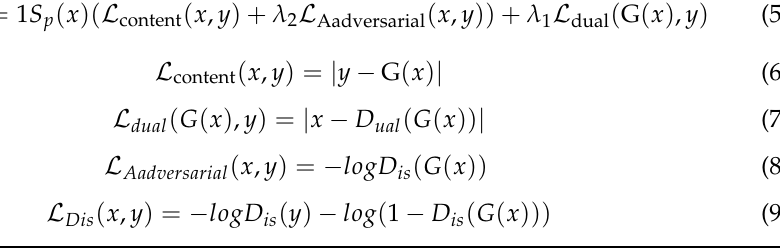
Algorithm 1 : Algorithm for Higher Resolution with Unpaired